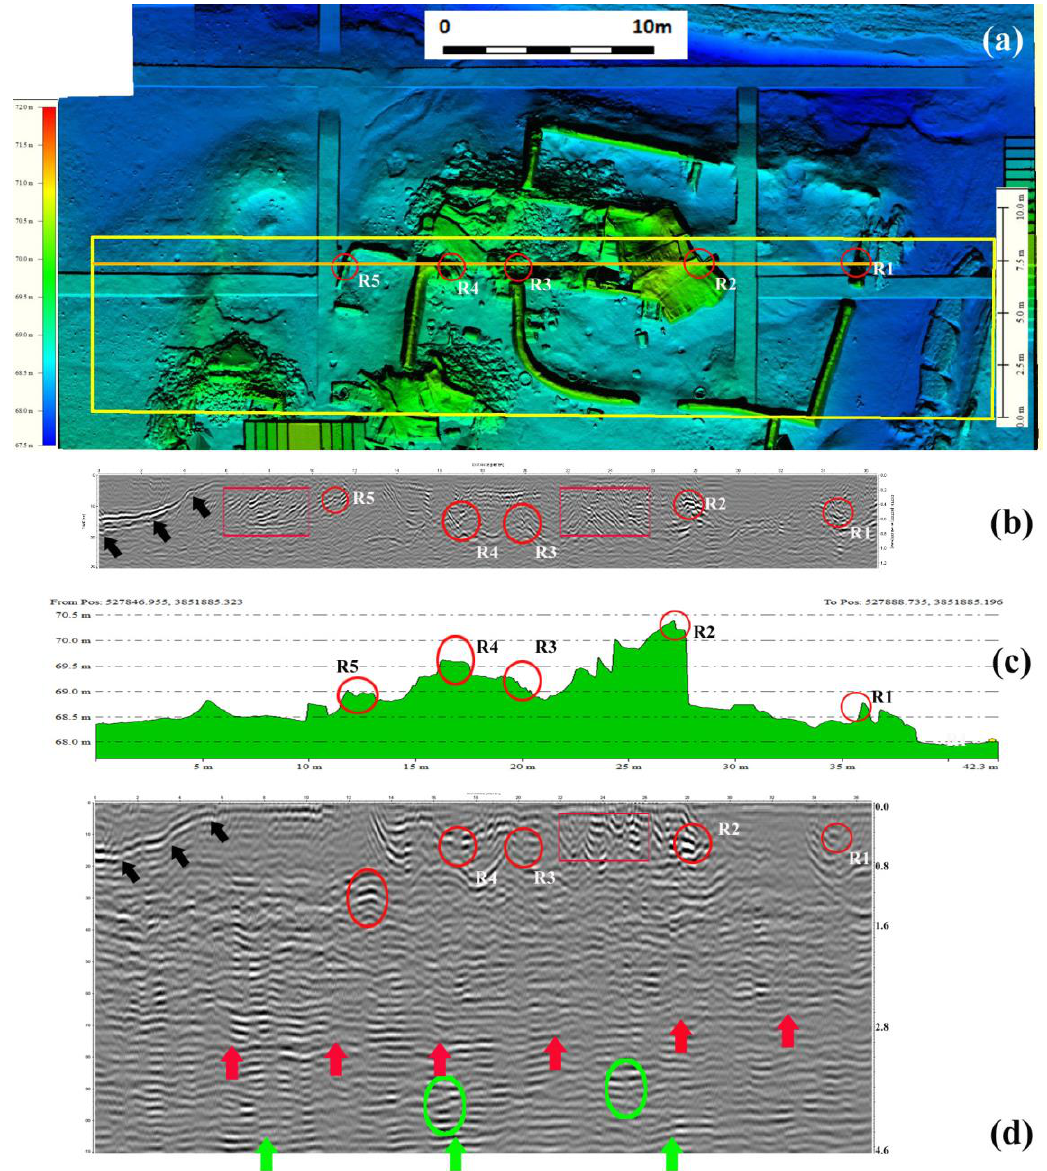
Figure 5. Comparative feedback of results from GPR profile at 7 m abscissa with archaeological findings. From up to bottom, respectively: ( a ) DEM provided by Laser scanning survey of remains unearthed by archaeologists, where the yellow box indicates the investigated area by GPR. ( b ) Migrated radargram acquired by 600 MHz frequency antenna, in correspondence of the profile indicated with red line in ( a ); red circles evidence some local reflectors referable to walls (R1, R2 and R5), pottery (R3), residues of collapsed walls (R4). Finally, the red boxes evidence some further features of archaeological interest. ( c ) Height section in correspondence of the radargram: red circles denote top of walls and other structures though to be possible reflectors; ( d ) migrated radargram acquired at 200 MHz frequency related to the same profile as ( b ); most of the reflectors observed from 600 MHz radargram are also visible. Finally, red and green arrows denote reflectance surfaces referable to floors of different historical phases likely referable to Qing and Ming Dynasty, respectively. Please, note that the strips oriented in North-South and East-West in the DEM in Figure 5a are the borders of the excavation grids.